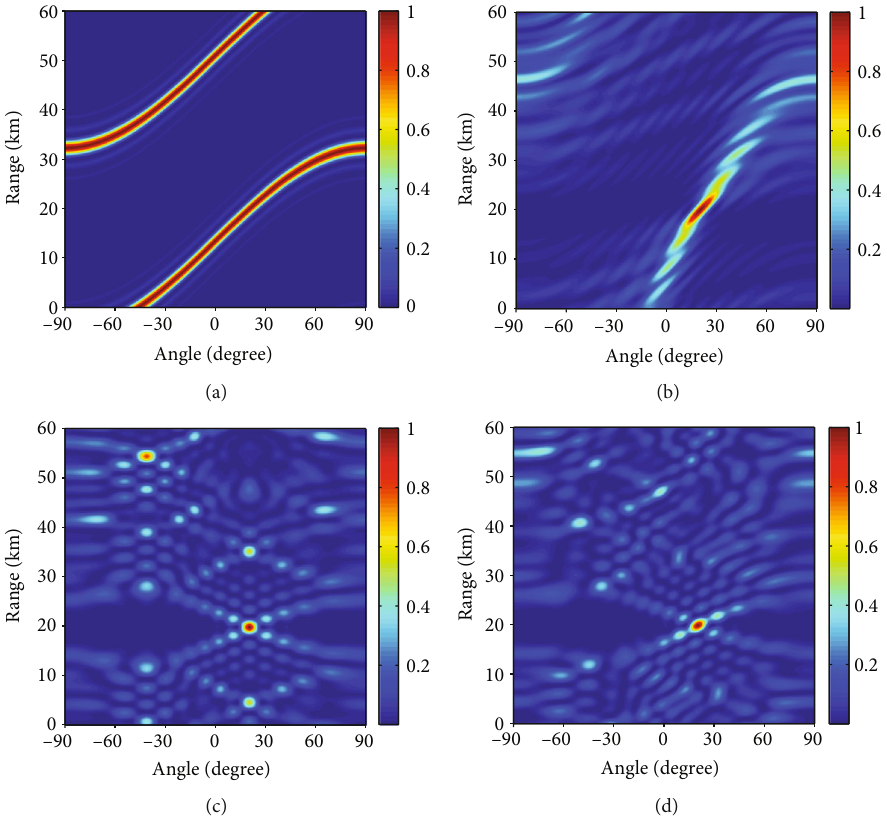
Figure 4: The equivalent transmit beampatterns at the receiver of (a) conventional linear FDA, (b) log-FDA, (c) Hamming-FDA, and (d) the proposed